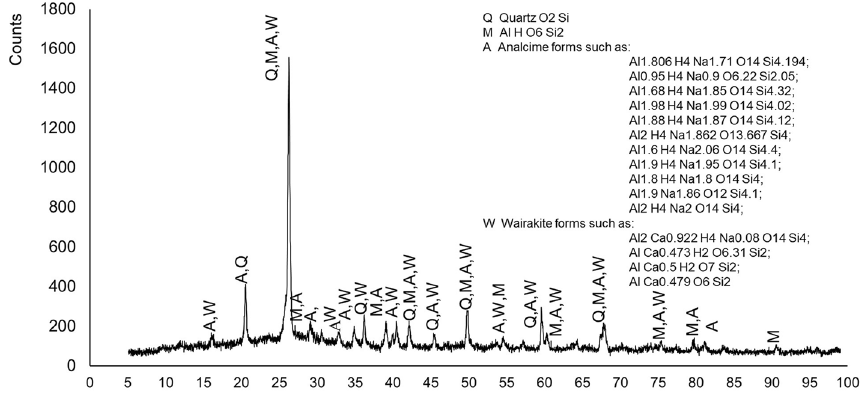
Fig. 10 X-ray diffraction analysis test results for 6% lime content fly ash geopolymer mortar after steam curing for 2